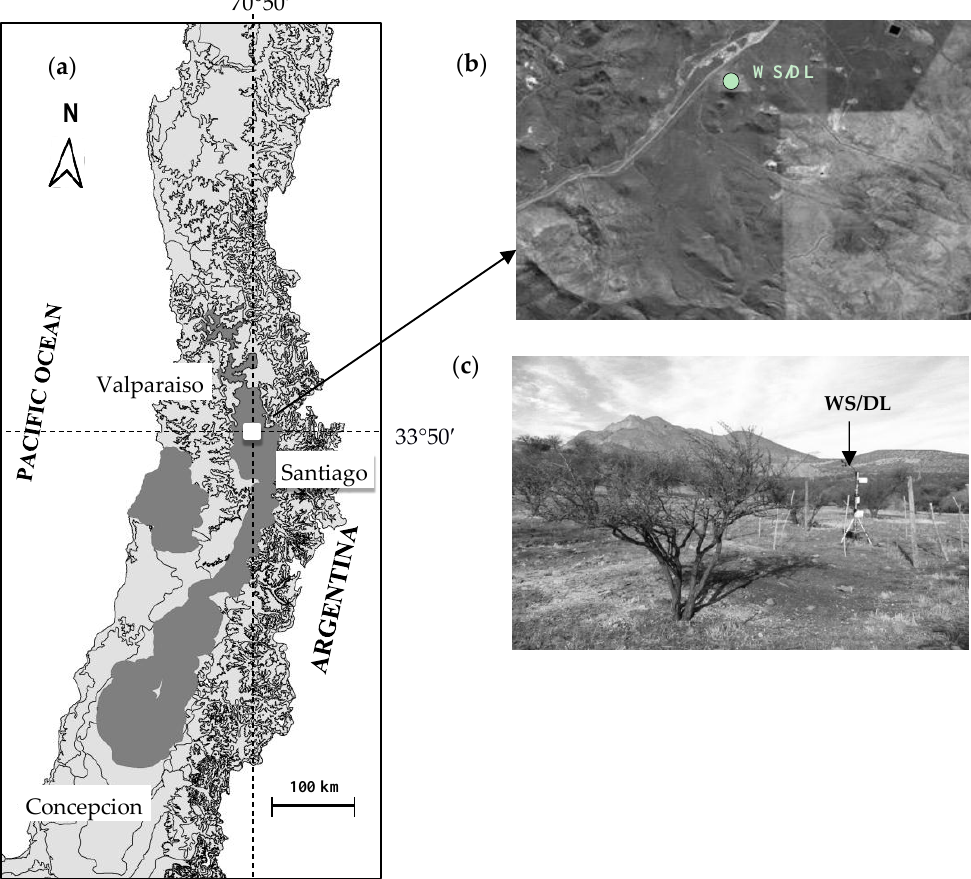
Figure 1. ( a ) Location of the study area (white square) in central Chile. The gray area indicates an estimation of the extension of the Acacia caven savanna [24–26]. ( b ) The open circle indicates the location of the weather station (WS) and data loggers (DL) within the watershed. ( c ) Photograph of the Acacia caven savanna showing the enclosure within which the weather station (WS) and data logger (DL) were located.